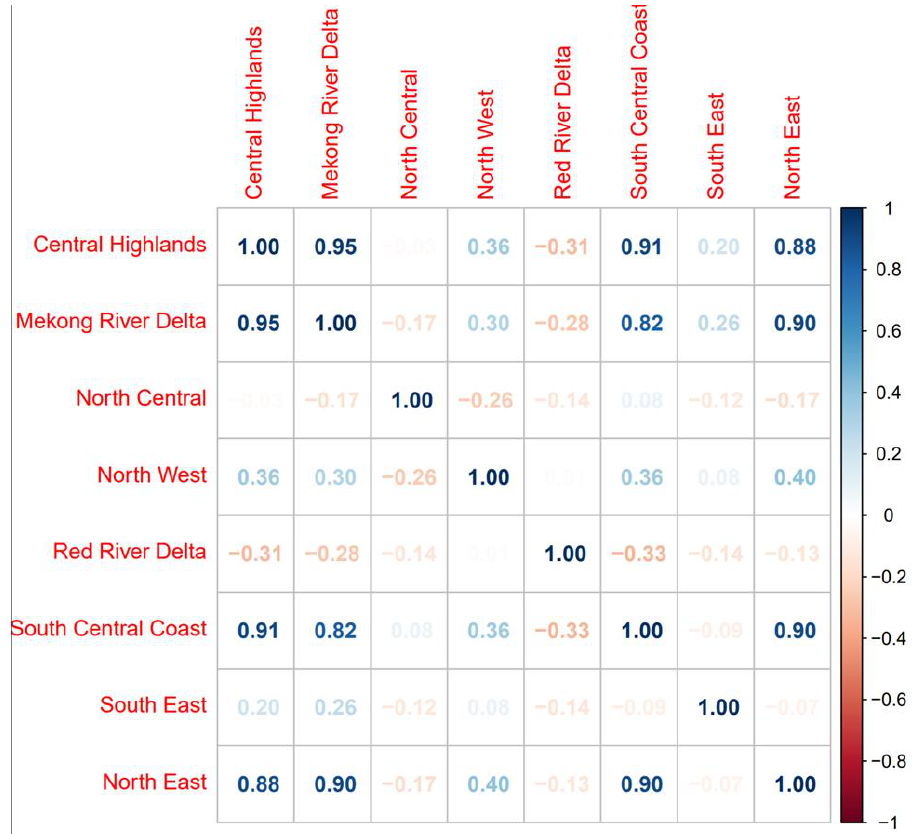
Figure 4. Spearman’s correlation matrix of reported case counts across agricultural zones from 2007–2017. Higher correlation values are shown in darker blue colors and negative correlation values are shown in red color according to the scale shown on the right side.